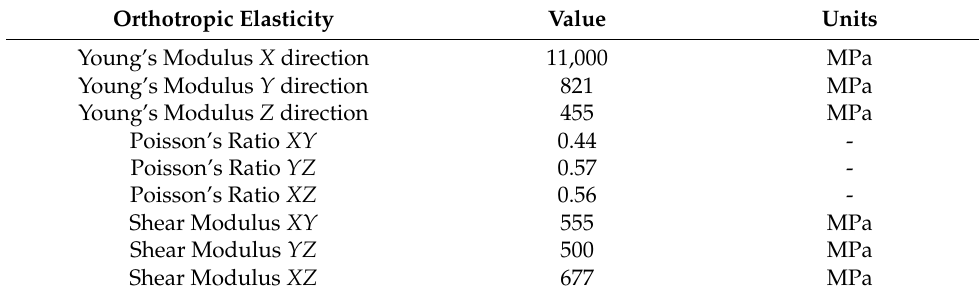
Figure 12. The 3D computational model: ( a ) detail no. 1; ( b ) detail no. 2. Table 4. Elastic constants of the material model of wood in the ANSYS TM program.